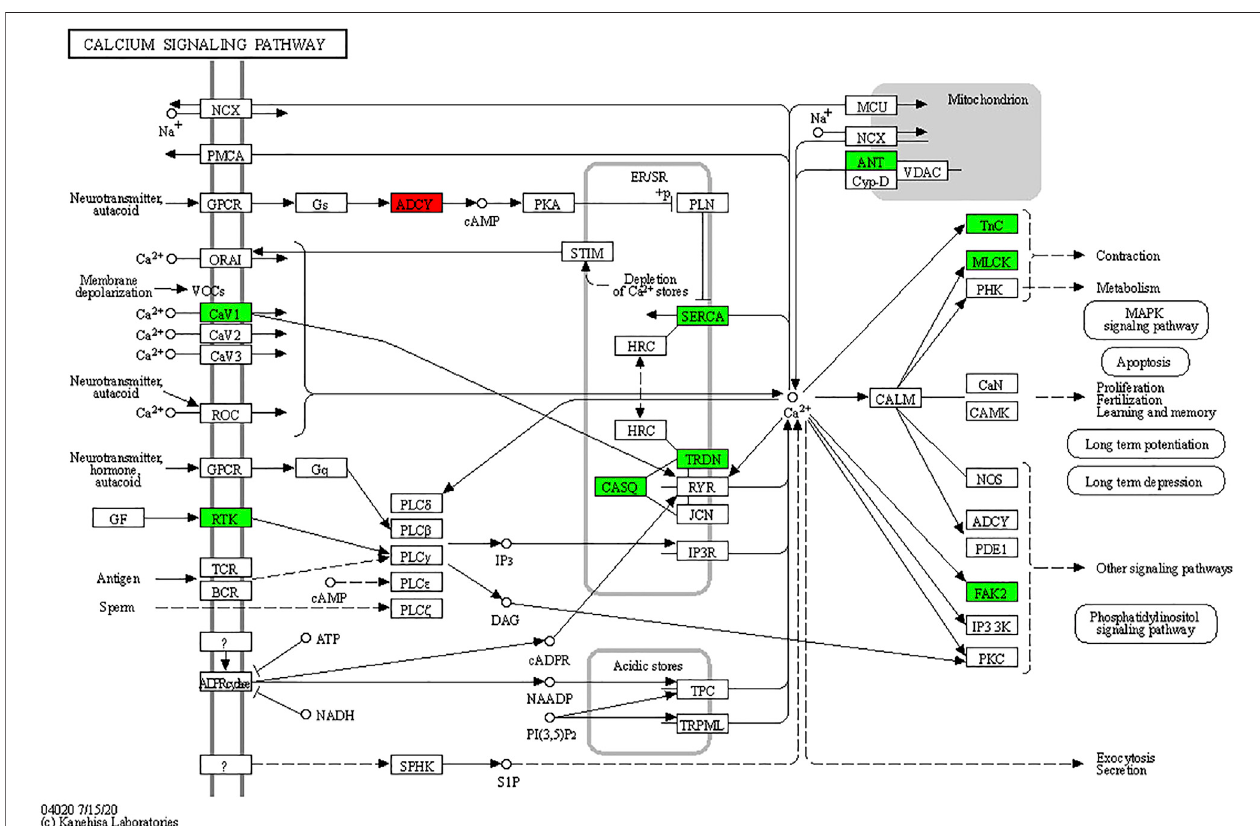
FIGURE 8 | KEGG map of the calcium signaling pathway. The red and green boxes indicate the up-regulated and down-regulated proteins through TxIB administration.